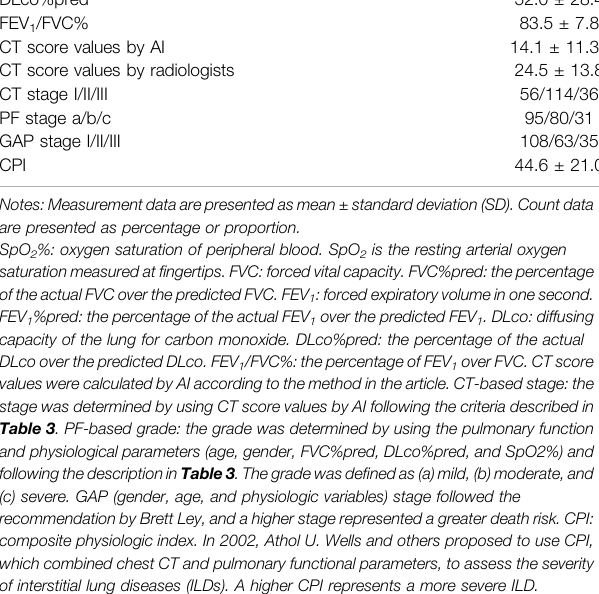
three CT stages.